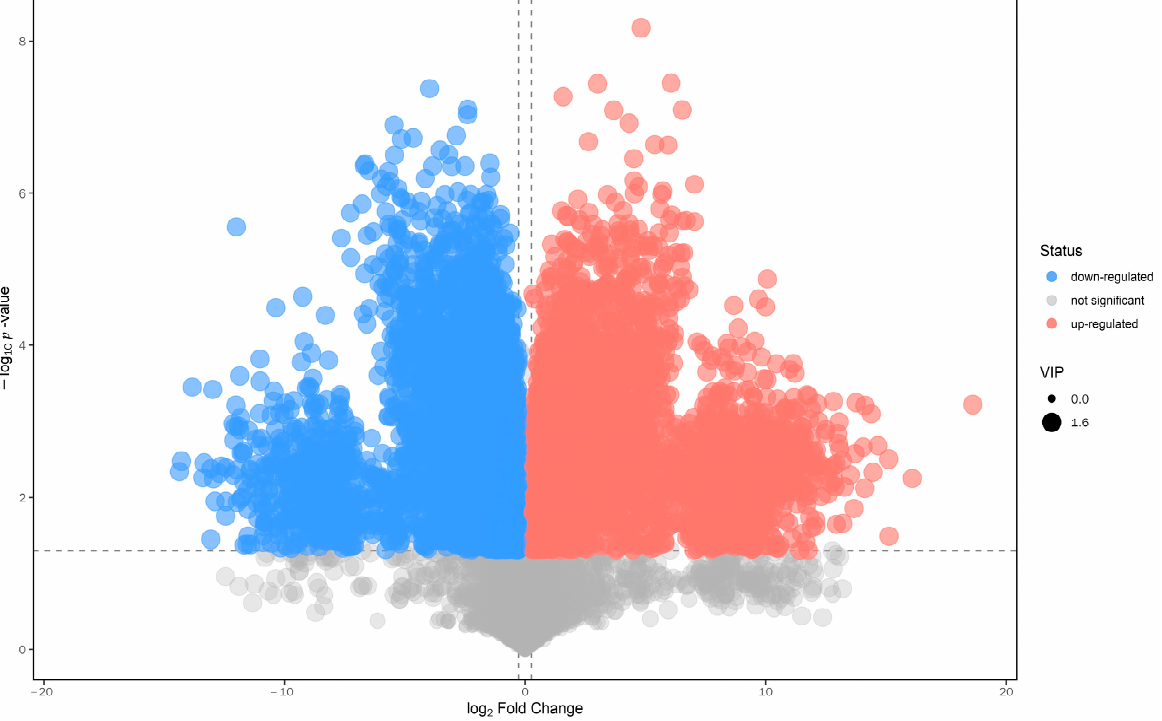
Figure 3. Volcano plot for group SHLF vs. SHL) ( A ) Positive ion mode; ( B ) Negative ion mode. Red dots, blue dots, and gray dots represent significantly upregulated, significantly downregulated, and insignificantly different metabolites, respectively.